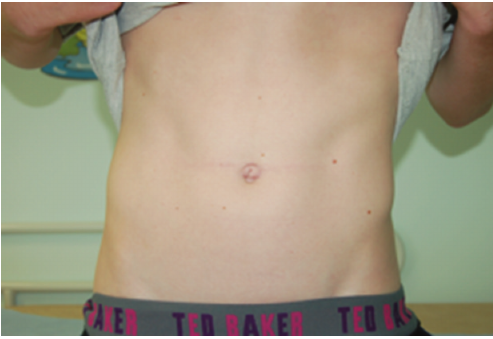
Figure 1: Clinical photograph of a 14-year-old patient 12 weeks following a SILS Palomo procedure.